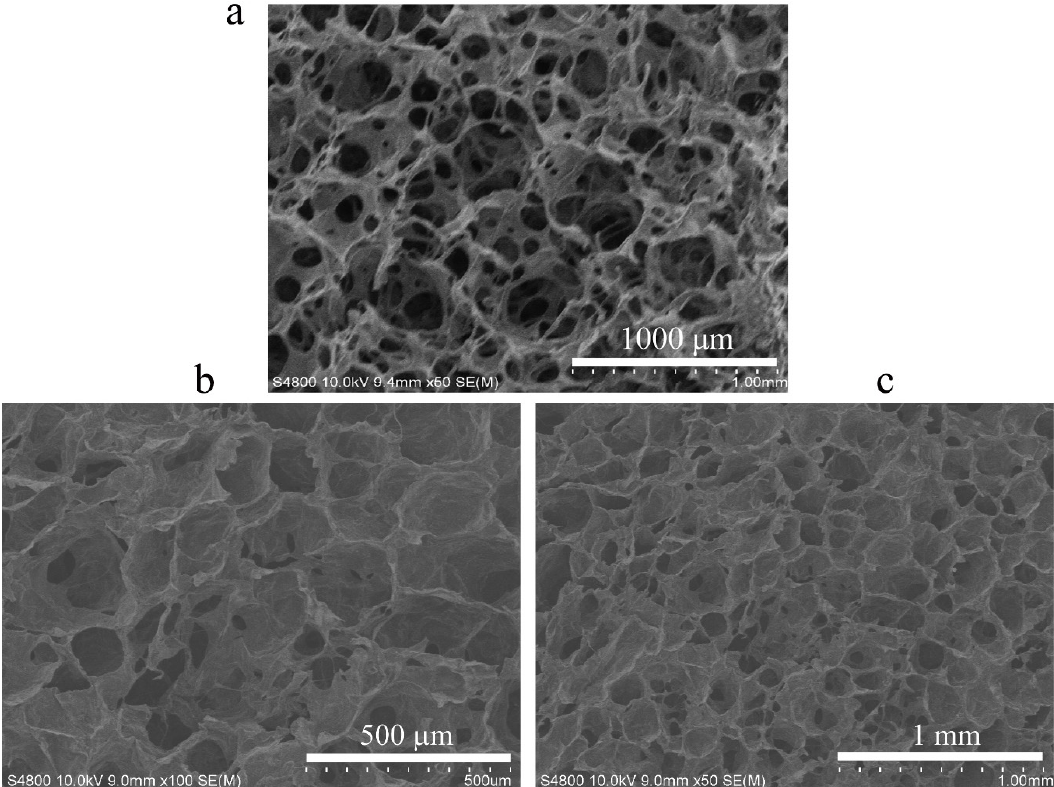
Figure 1. Scanning electron microscope (SEM) images of commercial gelatin sponge ( a ) and chitosan-based thermo-sensitive hydrogel loading oyster peptide (CS-C / OP / β -GP) hydrogels ( b , c ).